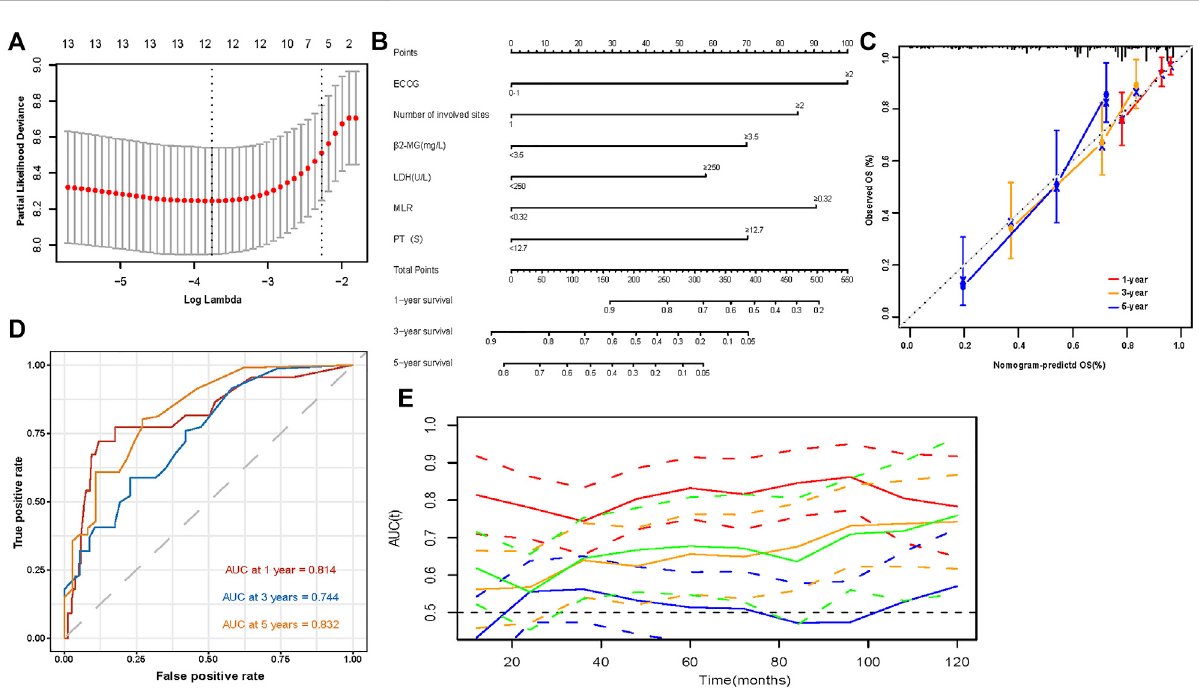
FIGURE 3 Developmentandevaluationofapredictivemodel (A) 1000 bootstrap replicatesbyLasso Cox regression analysis for variable selection; (B) The nomogram based on data from 217 patients with primary EMM to predict individual prognosis; (C) Calibration curves for predicting OS at 1-, 3-, and 5-year; (D) Sensitivity and speci fi city at 1-, 3-, and 5-year of the predictive nomogram model were assessed in 217 patients by time-dependent ROC analysis; (E) Time-dependent receiver operating characteristic (ROC) curves (Nomogram [red], R-ISS [green], ISS [orange], DS